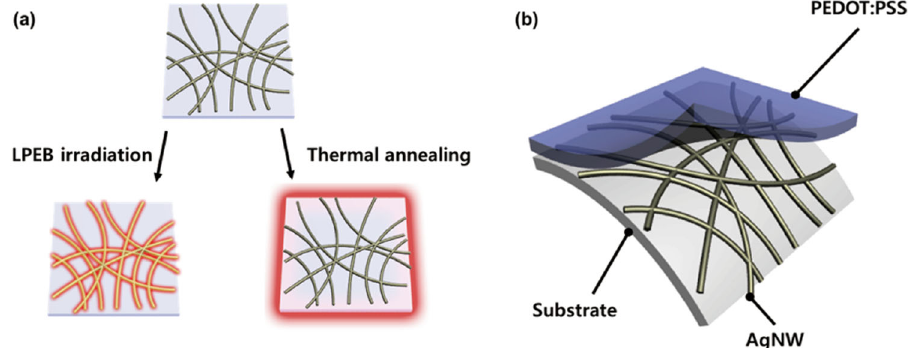
Fig. 6 a Schematic illustration of thermal annealing and LPEB irradiation of AgNWs. b Schematic illustration of fabrication process for AgNW/ PEDOT:PSS composite electrode and the PLED structure, and photograph of light-emitting fl exible PLEDs with AgNW/PEDOT:PSS electrode